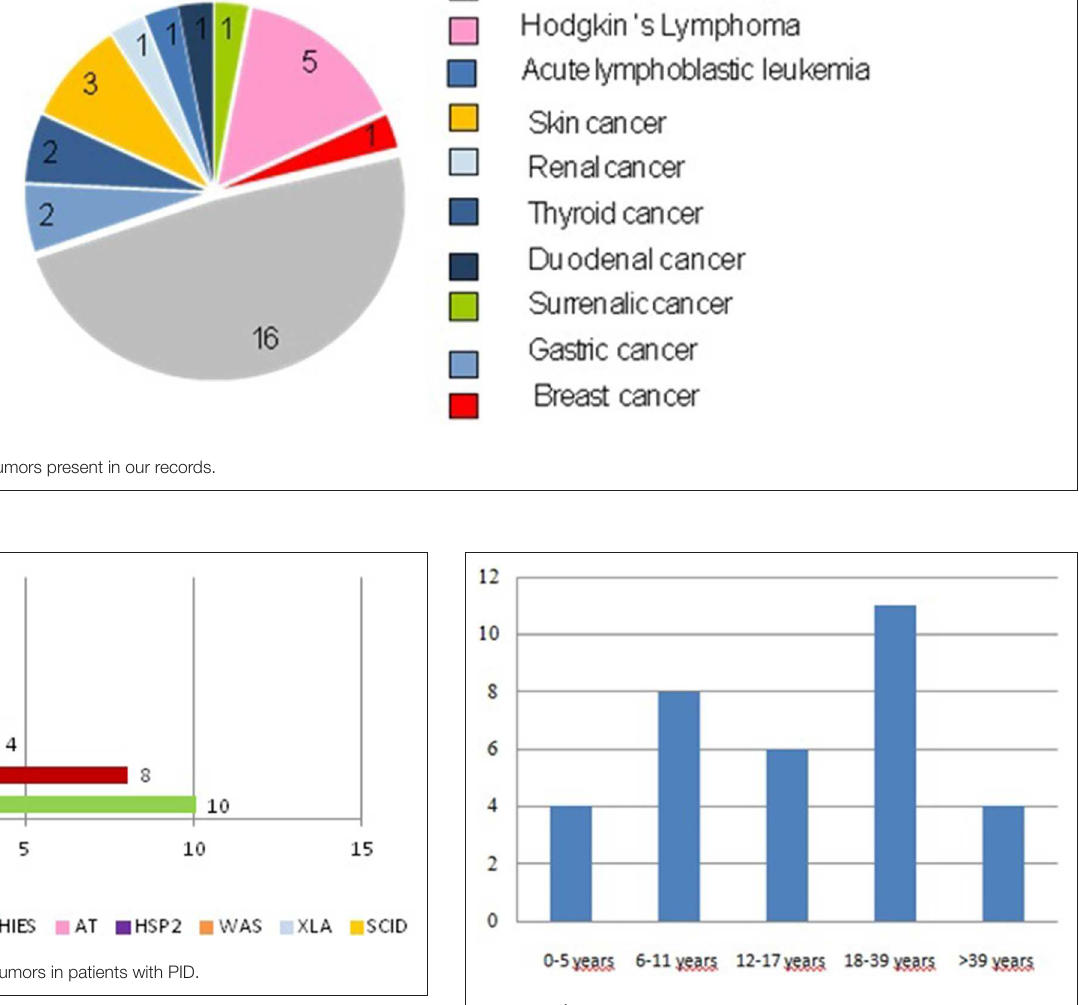
FIGURE 4 | Age of tumor